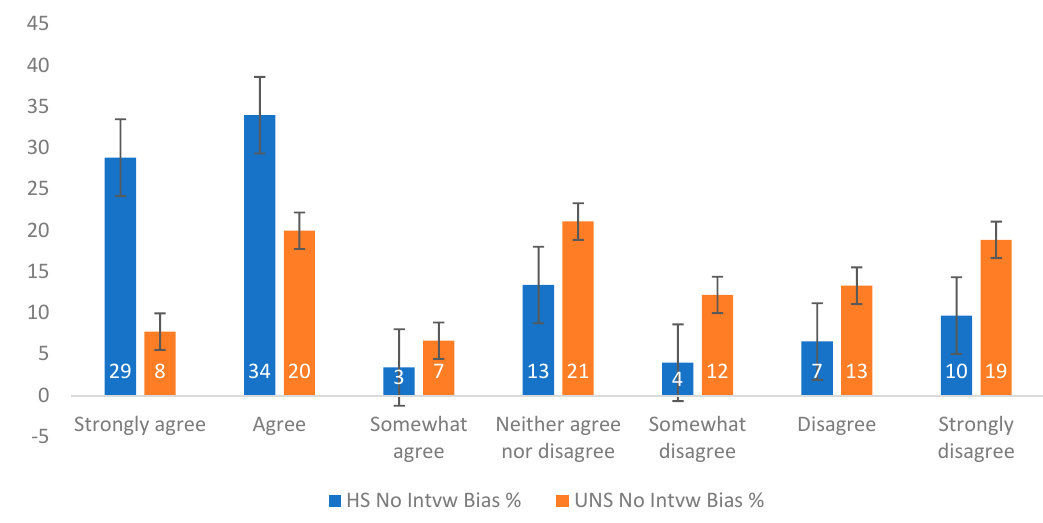
Figure 16. No bias of any sort in the hiring decision.